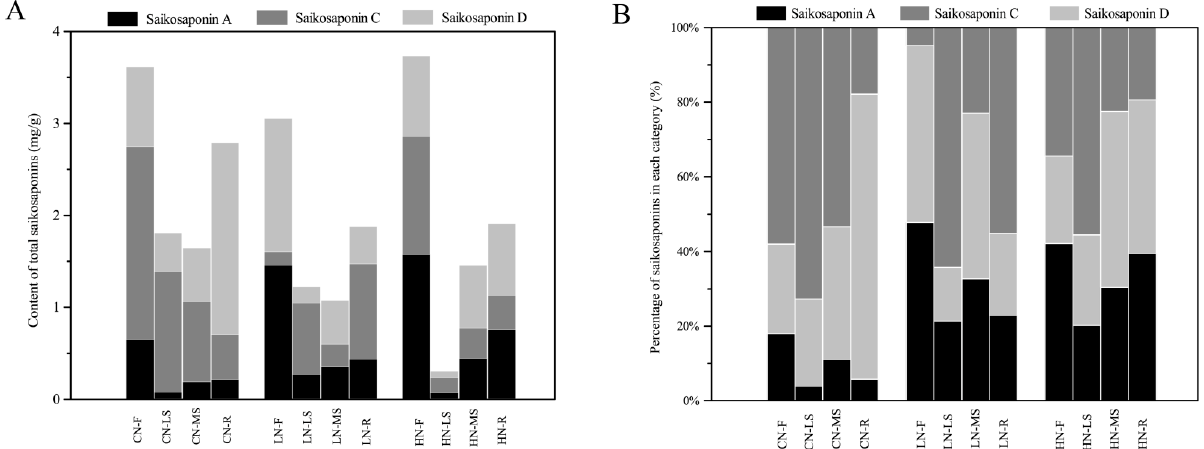
Figure 2. Saikosaponins content at three nitrogen fertilization levels within four organs. ( A ) Total saikosaponins content, including saikosaponin A, saikosaponin C and saikosaponin D; ( B ) The percentage of saikosaponin A, saikosaponin C and saikosaponin D content. Three nitrogen fertilization levels: control nitrogen group (CN), low-nitrogen (LN) and high-nitrogen group (HN); four organs: flower (F), main shoots (MS), lateral shoots (LS) and root (R).